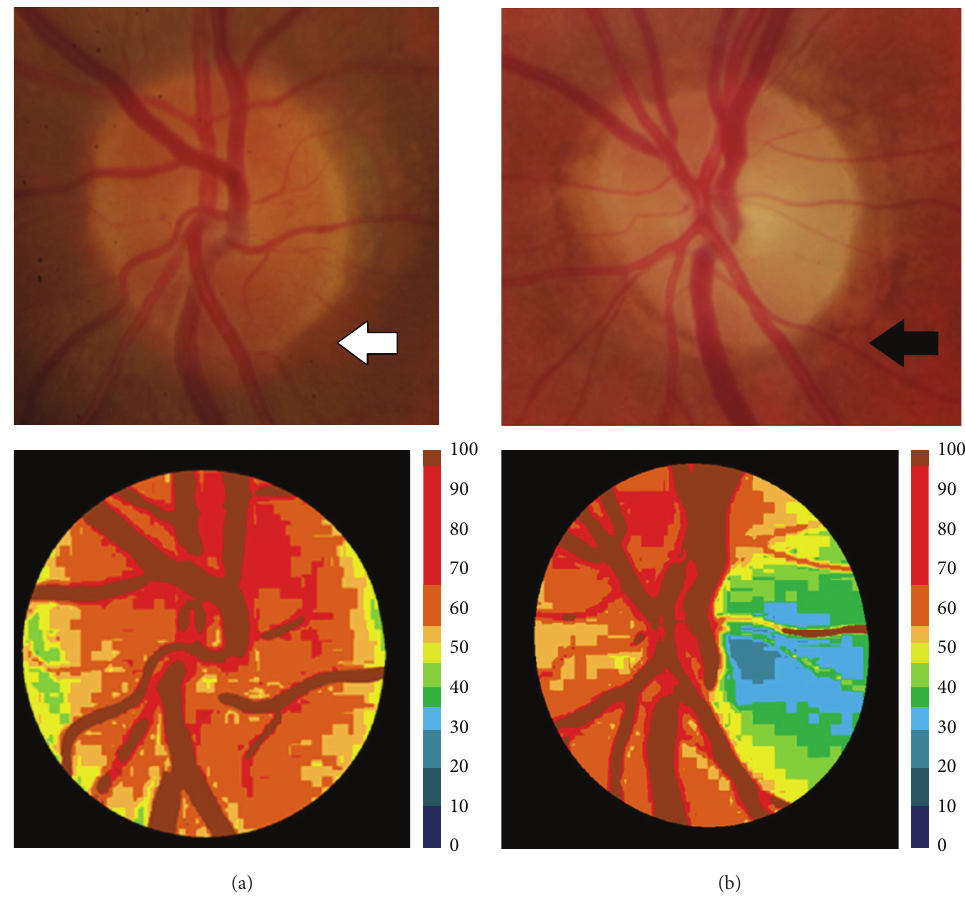
Figure 2: Examples of papillary images in a healthy subject (left column) and a Parkinson’s disease patient (right column). Upper images show the color fundus photographs of the optic discs (the white arrow marks the papilla of a healthy subject, and the black arrow marks the papilla of a Parkinson’s disease patient). The main parts of a healthy optic nerve can be distinguished in the upper-left image (white arrow): a small “yellow-white” depression is formed in the center of the papilla, which is referred to as the optic cup, to contrast it with the “orange” surrounding neural tissue that is referred to as the neuroretinal rim. Lower images show the corresponding pseudoimages representing the amount of hemoglobin. The colorimetric scale at the right side of the lower images shows the amount of